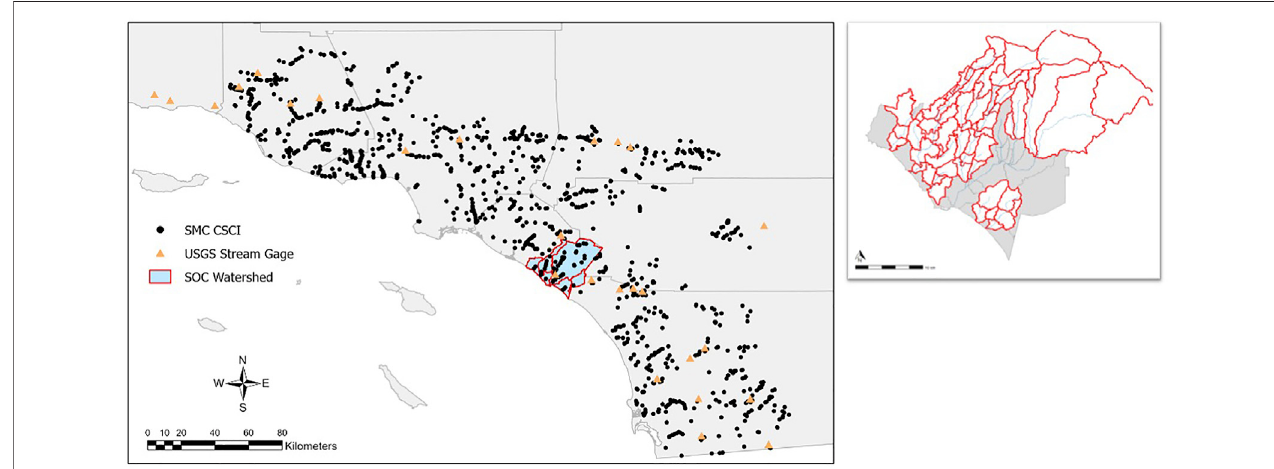
FIGURE 2 | Percent impervious surfaces of all subbasins in SJHI and location in California state. NLCD 2019 urban impervious raster. 4